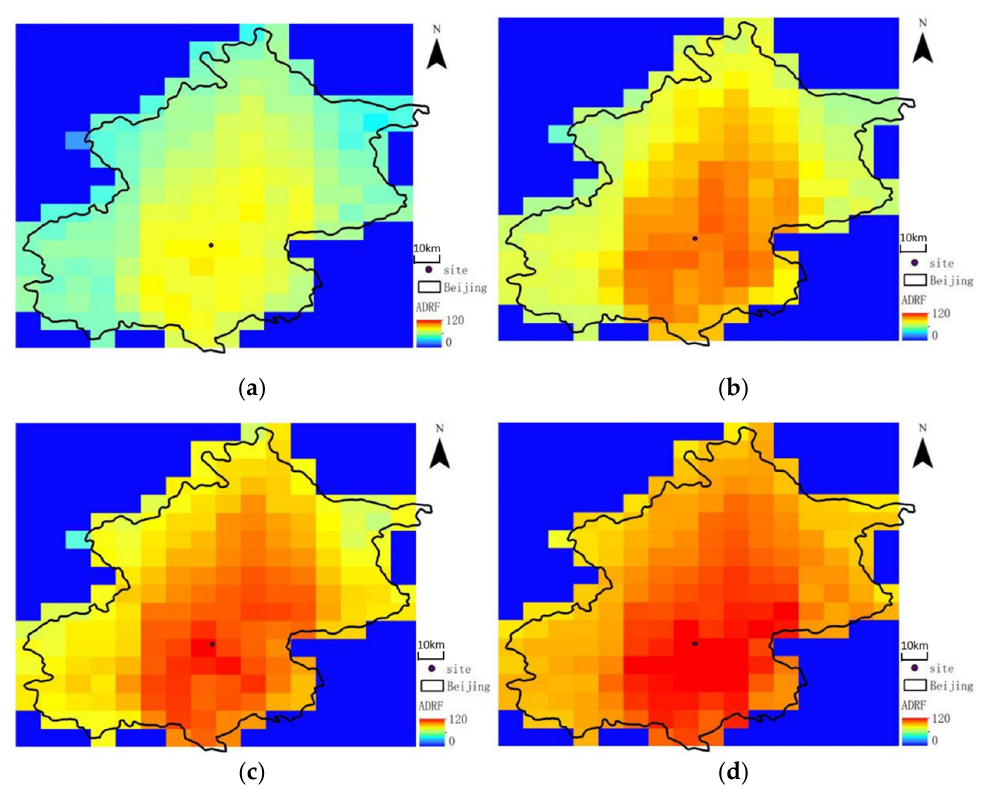
Figure 8. Distribution of ADRF at ATM under different degrees of pollution (from no pollution to severe pollution, ( a – d ).